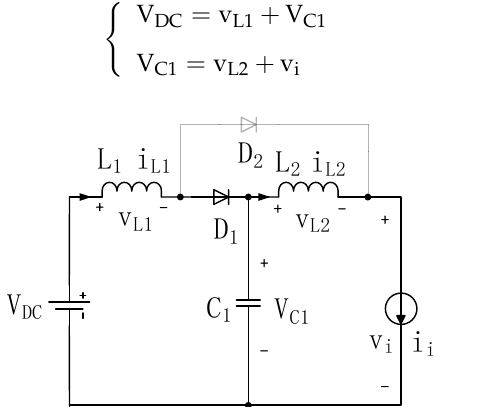
Figure 3. The equivalent circuit of the half quasi-Z-source in the non-shoot-through zero state.